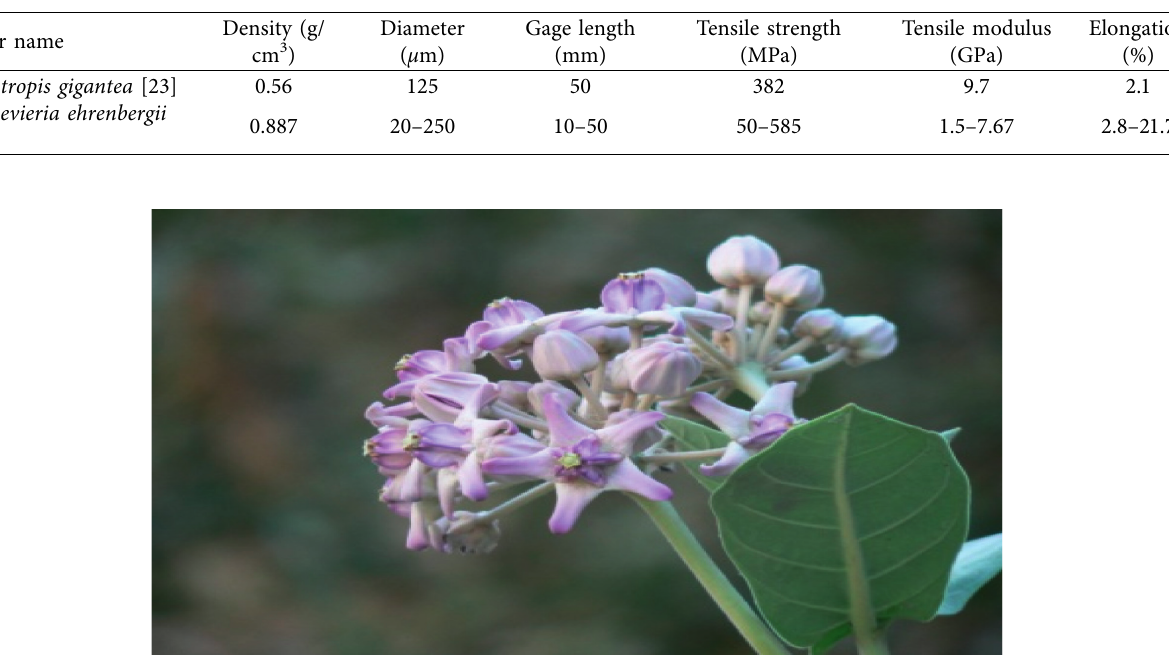
Figure 2: Calotropis gigantea .